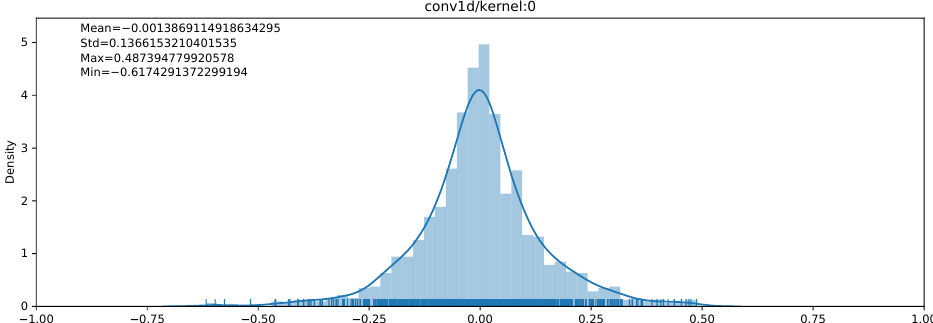
Figure 1. Example of the distribution of weights for a convolutional layer